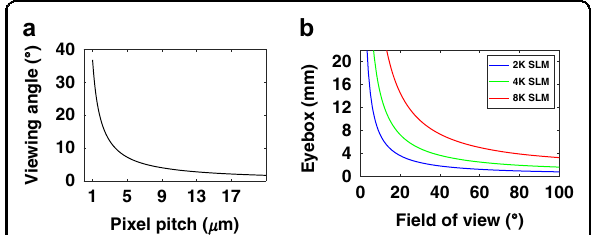
Fig. 5 The FoV and pixel pitch in LCoS devices. a Relationship between the viewing angle and pixel pitch. b Tradeoff between the eyebox and